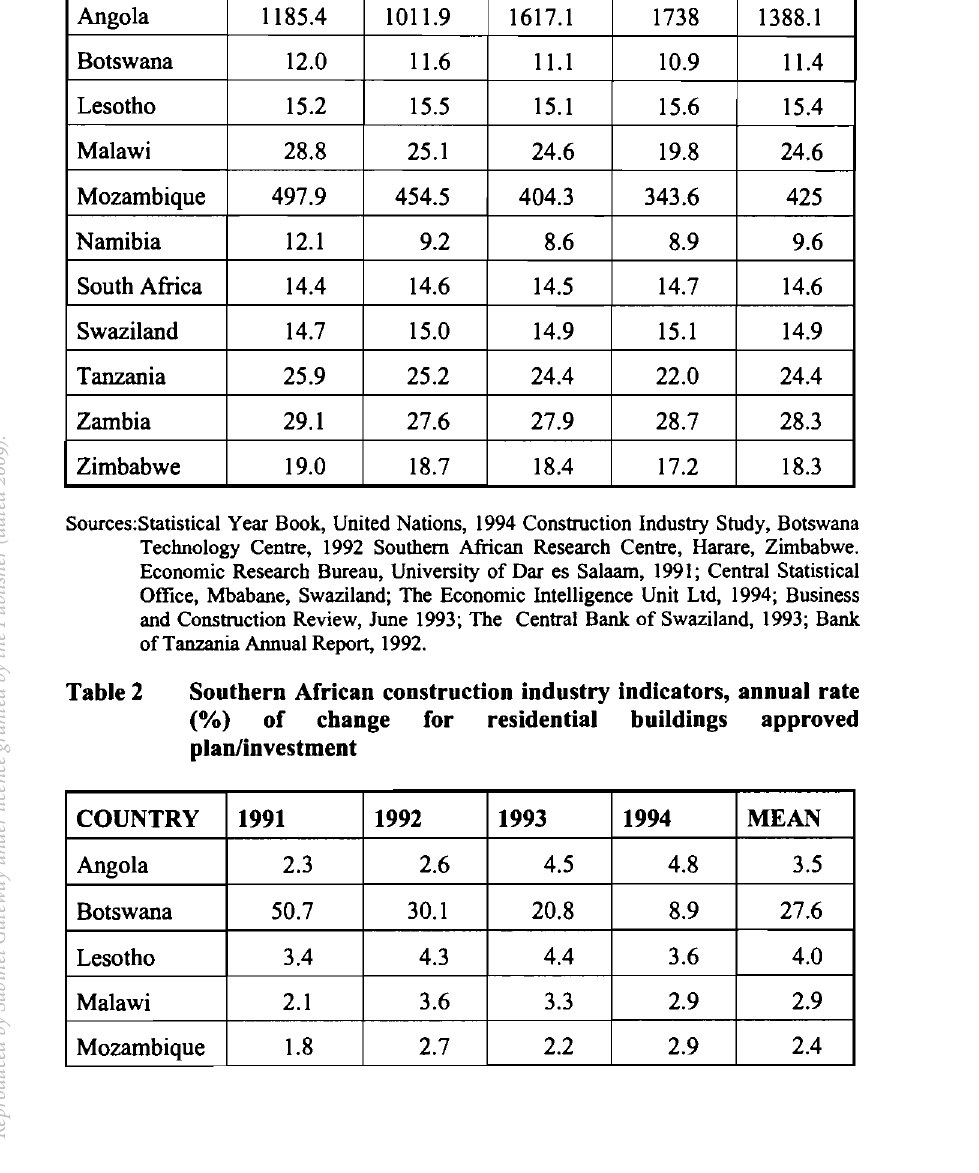
Average construction industry inflation rate (%) in southern African (SADC) countries COUNTRY